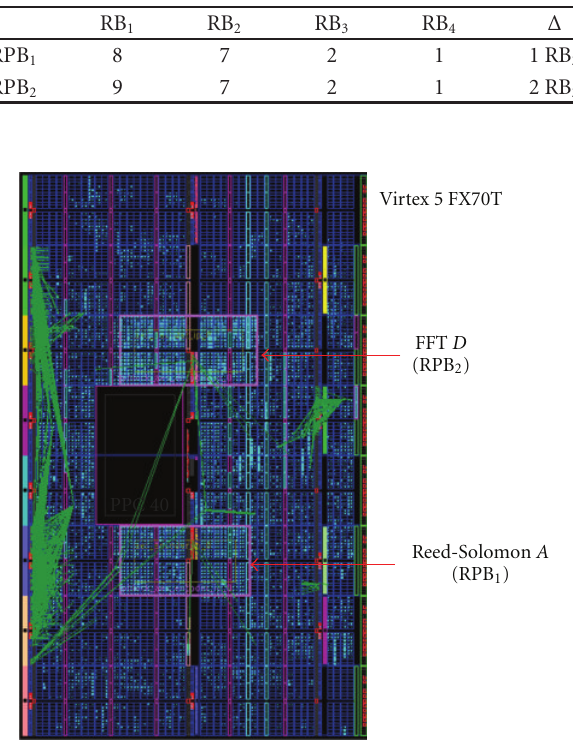
Figure 11: Floorplanning of RPBs and placing/routing of tasks A and D on Virtex 5